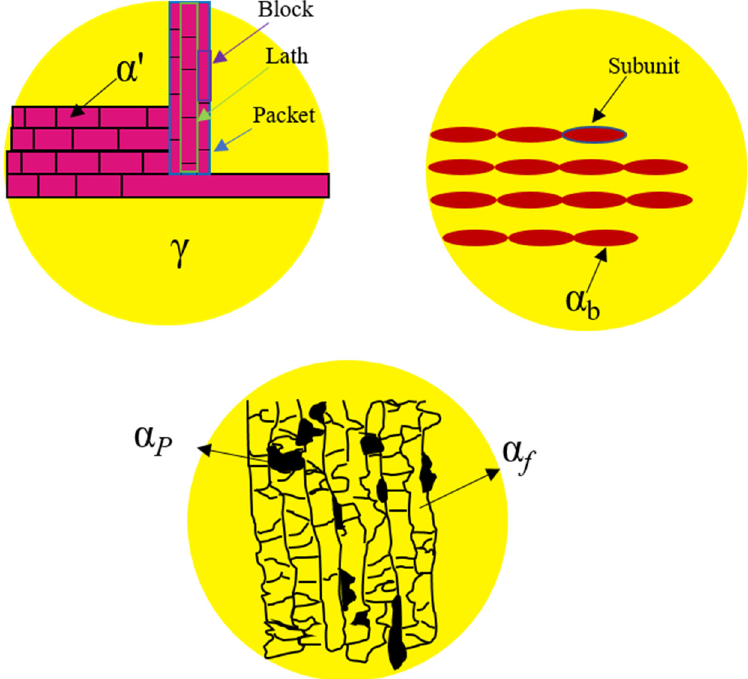
Figure 6. Schematic illustration on the formation of martensite, bainite, and ferrite + pearlite in the austenite grains (martensite: α ’; bainite: α b ; ferrite + pearlite: α f + α p ).